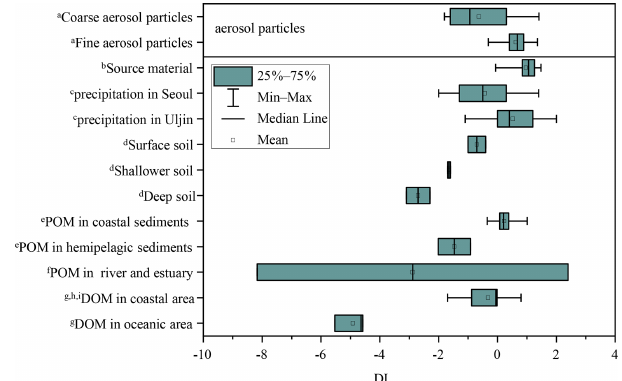
Figure 7. DI values of fine and coarse particles in comparison to other studies. a This study. b Source materials including phyto- plankton, bacteria, zooplankton and sediment trap material from Dauwe et al., 1999. c Yan et al. (2015). d Philben et al. (2018). e particle organic matter from McCarthy et al. (2007). f Wang et al. (2018). g Yamashita and Tanoue (2003). h Chen et al. (2016). i Ji et al.